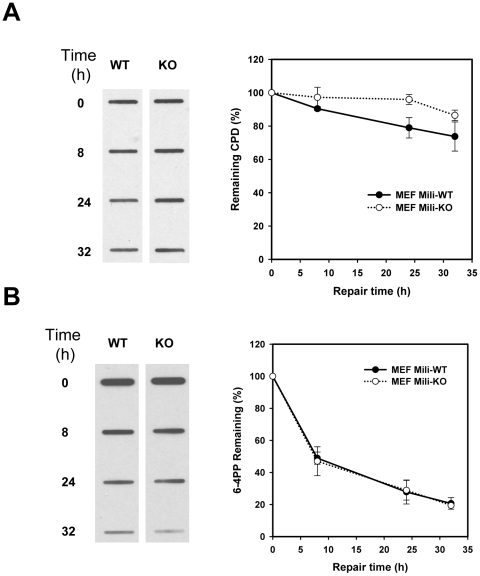
Piwil2 is required for repair of DNA damage induced by UV light.Mili-/- (KO) and WT MEFs were treated with 10 J/m2 UV light and examined for CPD (A) and 6–4 PP abducts (B) at various time points, using Immuno-slot blotting. The data shown are a representative of two experiments. **, p<0.01.